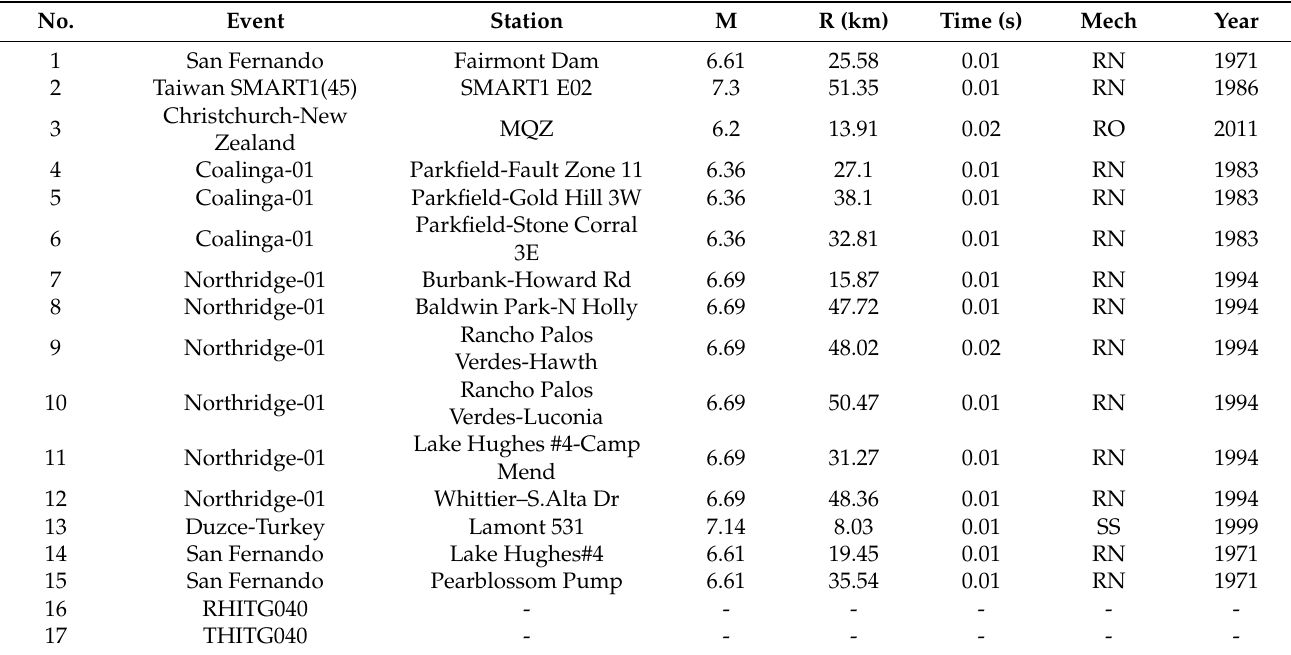
Figure 6. Illustration of the steps for generating fragility curves.